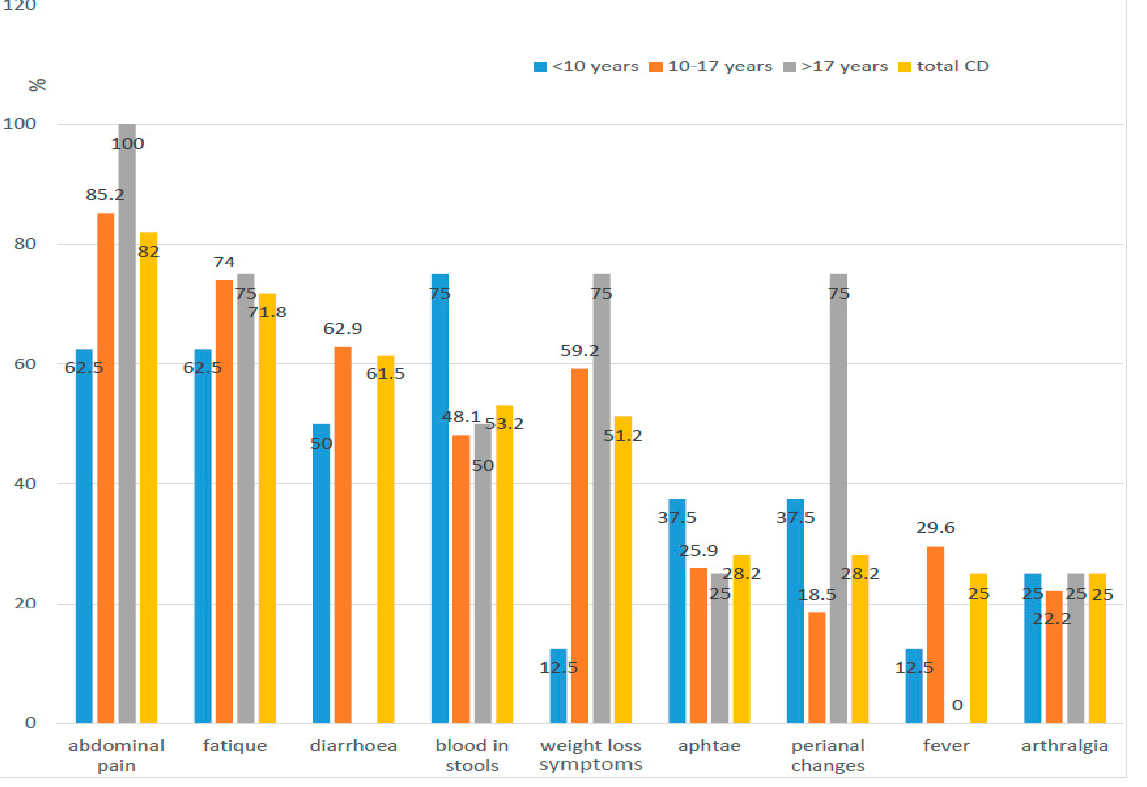
Figure 2. Correlation between symptoms and age: CD—Crohn’s disease.